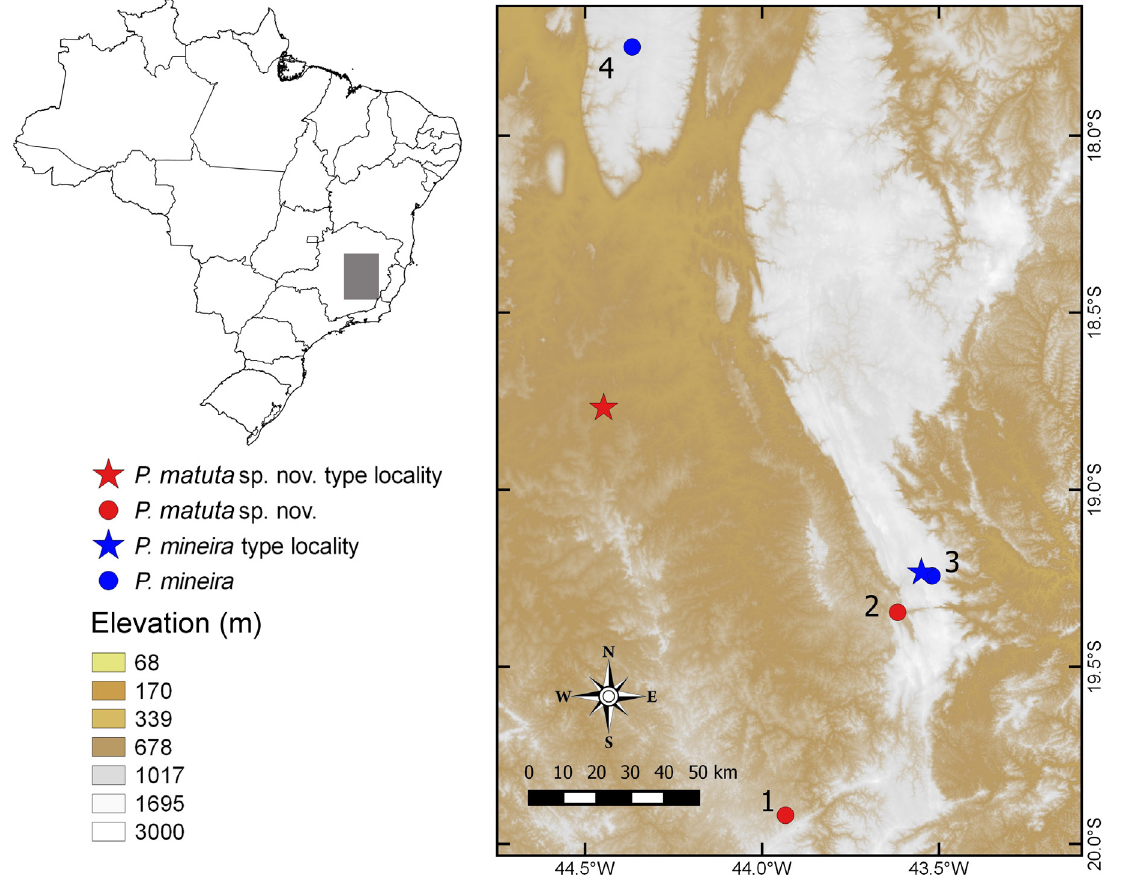
Fig. 1. Hypsometric map of the region highlighted on the map of Brazil (left), showing the samples of Pseudopaludicola matuta sp. nov. included in our molecular, morphological, and acoustic comparisons. The type locality of P . matuta sp. nov. in the municipality of Curvelo, is indicated with a red star. The map also highlights the known distribution (blue symbols) of P. mineira Lobo, 1994 and our record for this species. The type locality of P. mineira in the Serra do Cipó National Park is indicated with a blue star (Lobo 1994). Numbers: (1) Belo Horizonte; (2) lowlands of the Serra do Cipó National Park (near the park’s headquarters, in a lowland area), municipality of Santana do Riacho; (3) highlands of the Serra do Cipó National Park, municipality of Santana do Riacho (our data); (4) Serra do Cabral, municipality of Buenópolis (Lobo 1994). All represented points are in the state of Minas Gerais, Brazil. Legend also contains the altitude in meters of the hypsometric